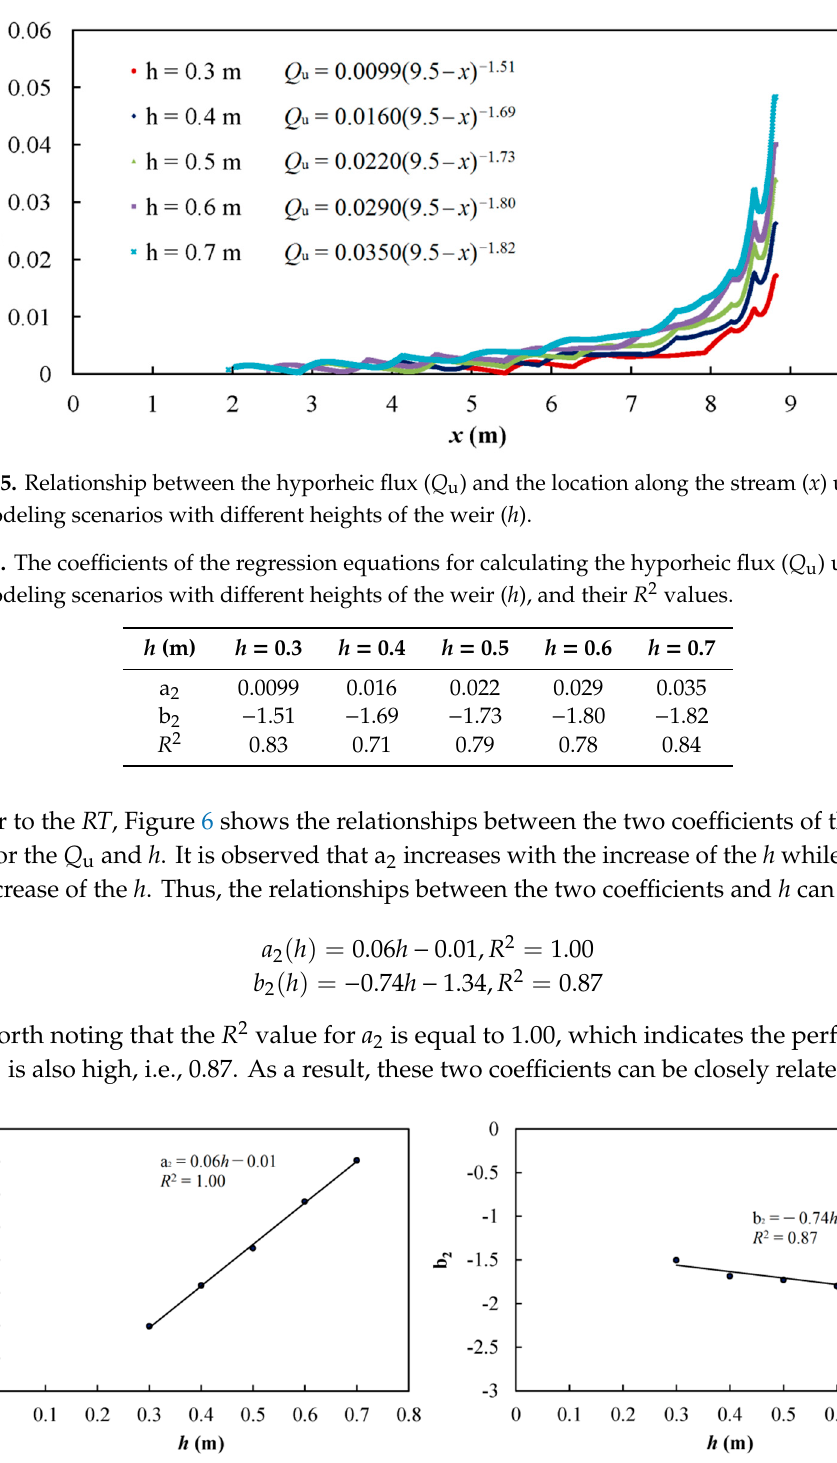
Figure 6. Relationship between the two coefficients of the regression equation for calculating the hyporheic flux ( Q u ) and the height of the weir ( h ).